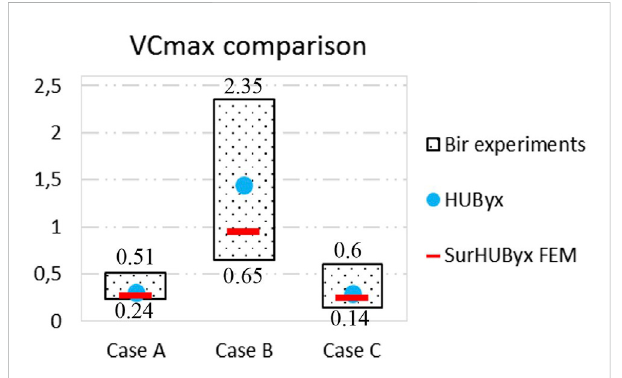
FIGURE 7 VCmax comparisons between cadaver experiments, HUByx and SurHUByx FEM.